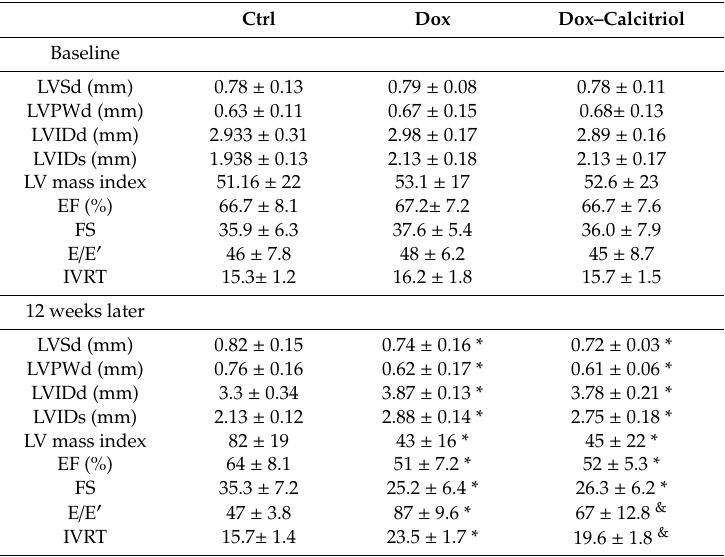
Table 1. Echocardiography analysis for the cardiac functions.